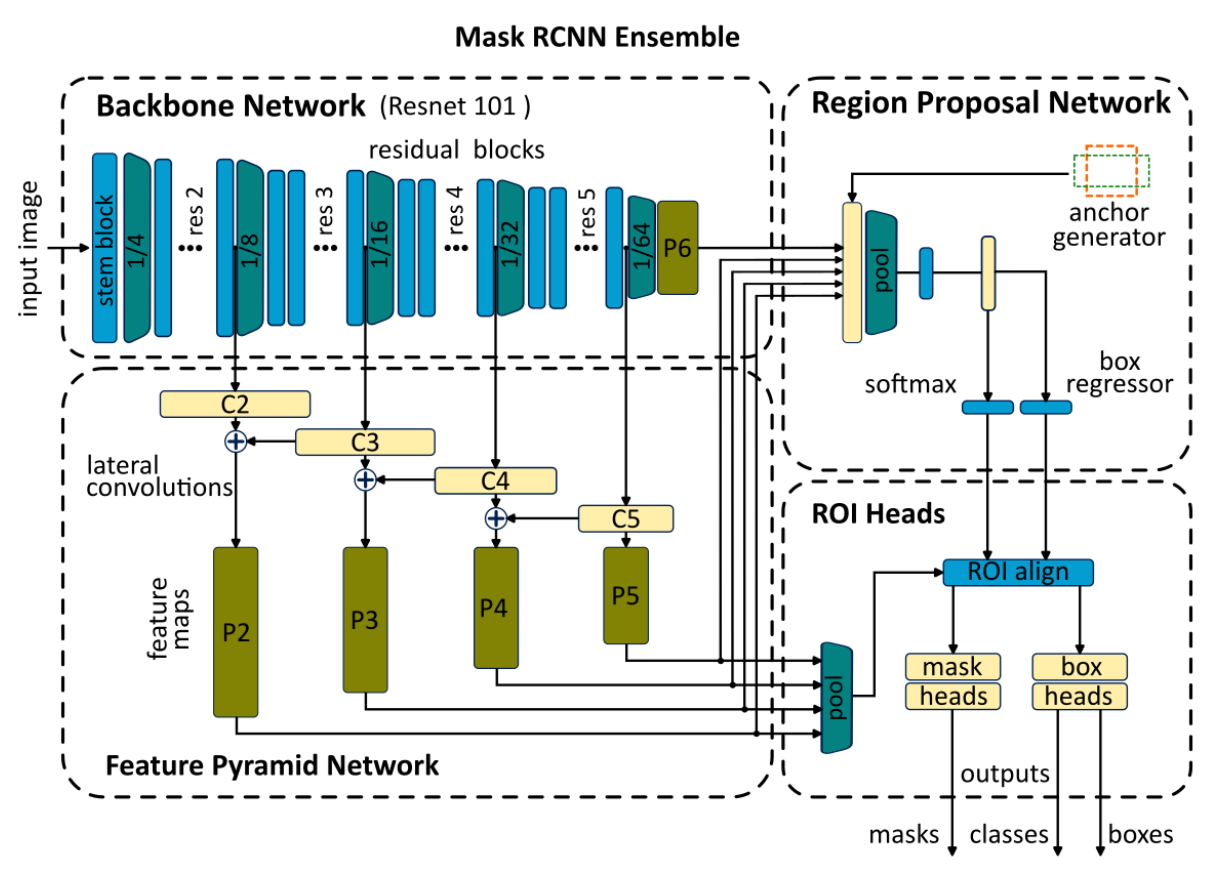
Figure 5. Basic schematics of a Mask RCNN